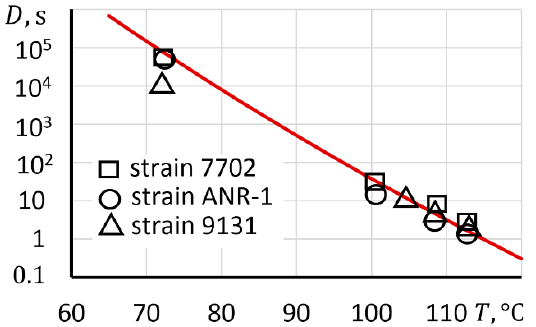
Figure 5. The data comparison of the heat resistance of B. anthracis spores in liquid to the calculations results.